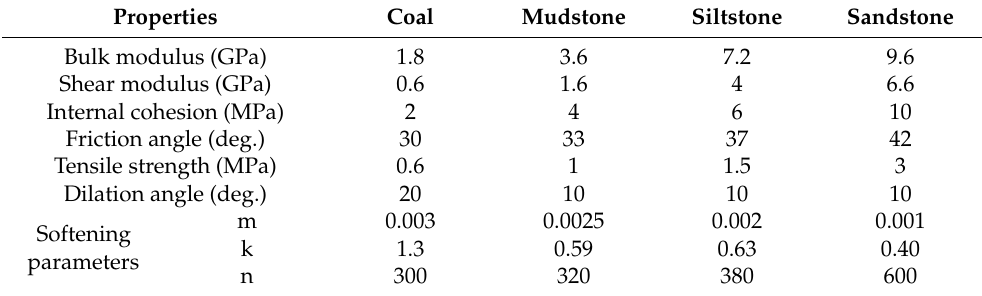
Table 2. Properties for numerical